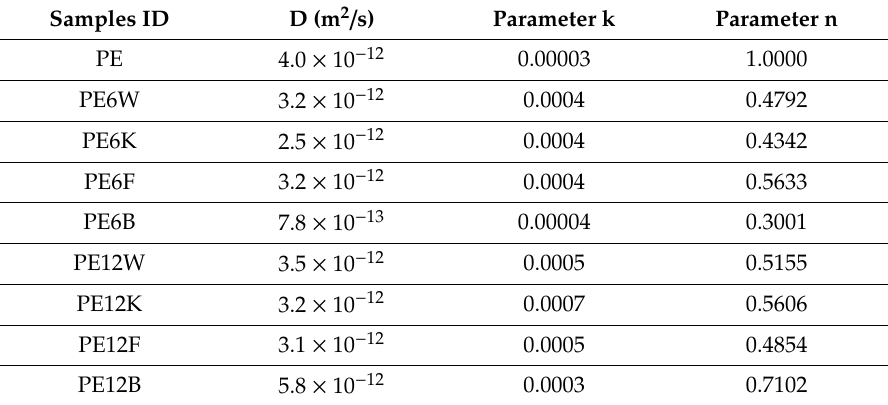
Table 6. Estimated parameters for di ff usion coe ffi cient and its kinetics.